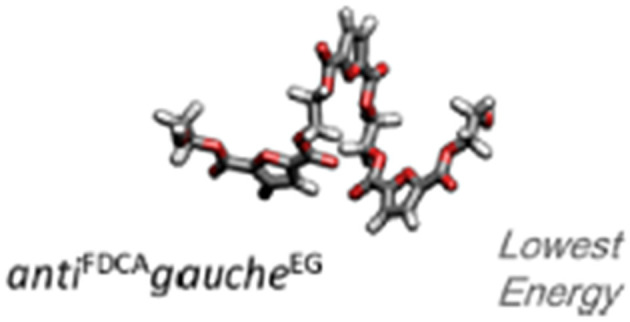
Optimized molecular geometry of a possible PEF oligomer at the B3LYP/6311+G(d,p) level of theory, in vacuo. Adapted with permission from Araujo et al. (2018). Copyright (2018) American Chemical Society.